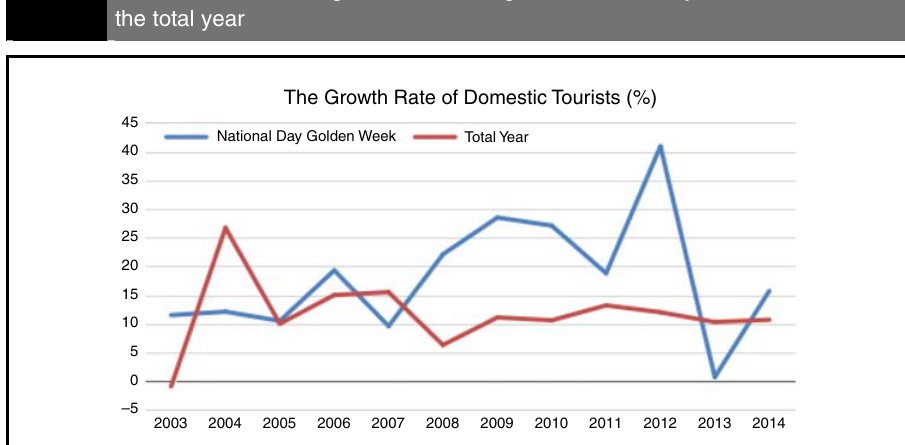
Figure 3 The domestic tourist growth rate during the National Day Golden Week